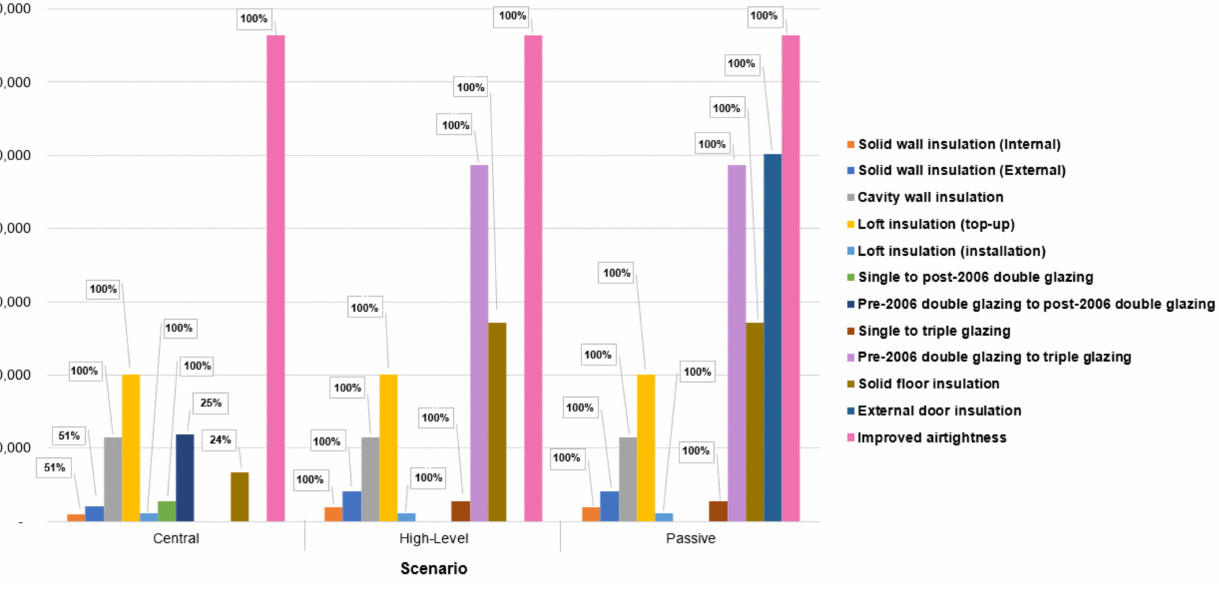
Figure 4. Uptake of measures across all scenarios by